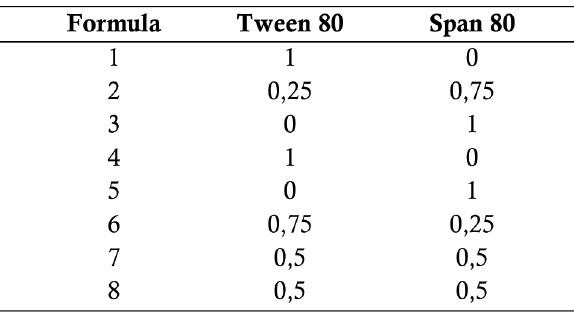
Composition of Emulsifier used for the preparation of Corn Silk Antioxidant Cream.